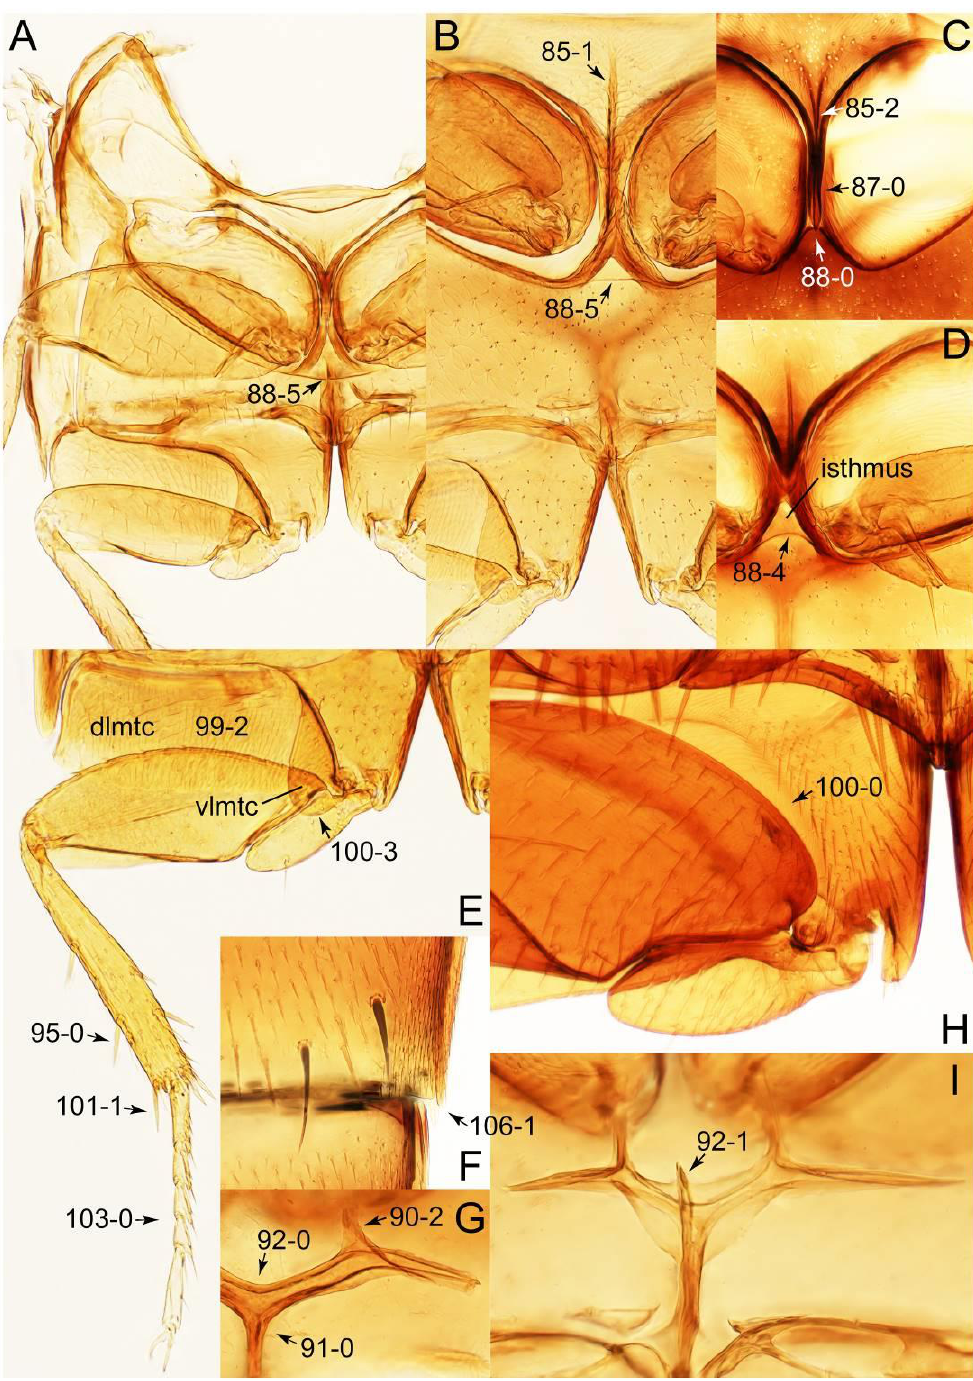
Figure 28. Photographs of body parts of Vatesini, enlarged. ( A ) mesothorax and metathorax of Mimocyptus sp., ventral view. ( B ) mesoventrite and metaventrite of Coproporus colchicus , ventral view. ( C ) intermesocoxal processes of Cilea limbifera , ventral view. ( D ) intermesocoxal processes of Termitoplus grandis , ventral view. ( E ) hindleg of Coproporus colchicus , ventral view. ( F ) posterior margin of sternite V of Vatesus praedatorius , ventral view. ( G ) metendosternite of Coproporus colchicus , dorsal view. ( H ) right metacoxa of Vatesus gigas , ventral view. ( I ), metendosternite of Coprotachinus habrocerinus , dorsal view. Abbreviations: dlmtc, dorsal lamella of metacoxa; vlmtc, ventral lamella of metacoxa. Characters and character states (format X-X) are indicated on each